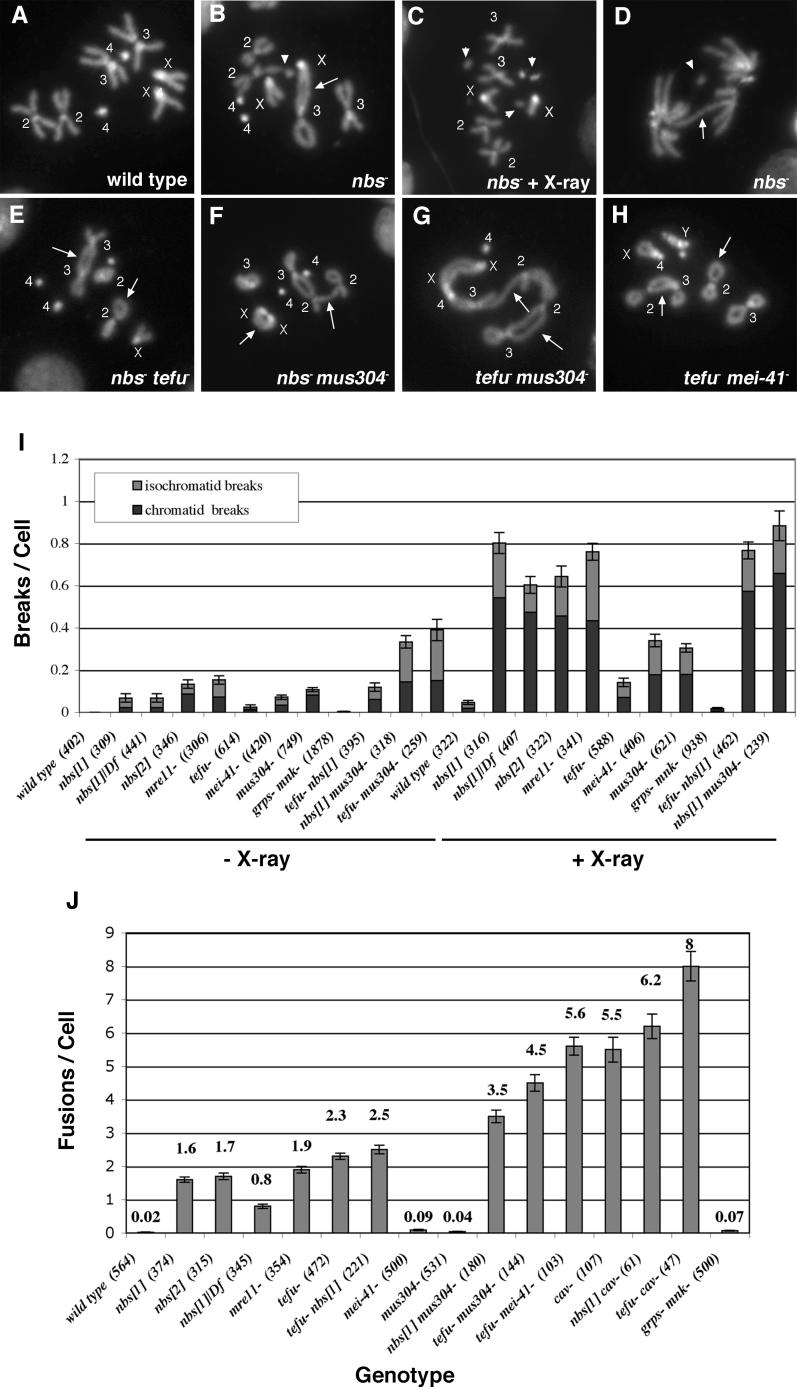

Drosophila nbs Acts with the tefu and mei-41-mus304 Pathways to Protect Cells from Telomere Fusions and Chromosome BreaksMitotic chromosome spreads were prepared from wild-type and mutant third-instar larval brains. Wild-type cells do not exhibit telomeric associations (A). nbs single mutant cells and nbs tefu double mutant cells exhibit DNA breaks (arrowheads) and telomere fusions (arrows) in metaphase (B, C, and E) and anaphase (D). Double mutant cells disrupting both the atm-nbs and atr-atrip pathways result in a more severe telomere phenotype, in which many telomeres are fused (F–H). The labels X, Y, 2, 3, and 4 refer to the relevant chromosome.The frequency of spontaneous (no X-ray treatment [− X-ray]) and damage-induced (treated with 100 rads X-rays [+ X-ray]) chromosome breaks is elevated in mitotic cells from nbs
− and other mutant animals (I). Both isochromatid (light shading) and chromatid (dark colored portion of the bar) breaks were counted as one break. The frequency of telomere fusions per cell is elevated in DNA damage response mutant cells (J). Double telomere associations were counted as two fusions. Individual genotypes are discussed in the Results section. The total number of cells scored for each genotype is in parenthesis. Error bars indicate the standard error of the mean.